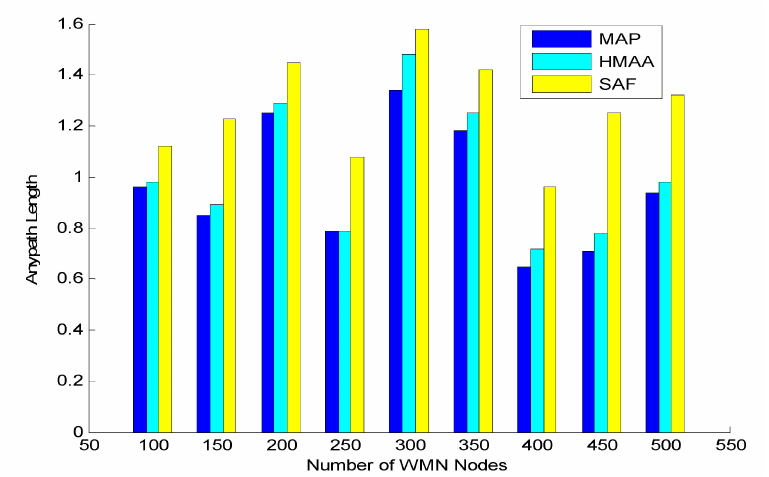
Figure 5. Anypath Length vs. number of nodes for MAP, HMAA and